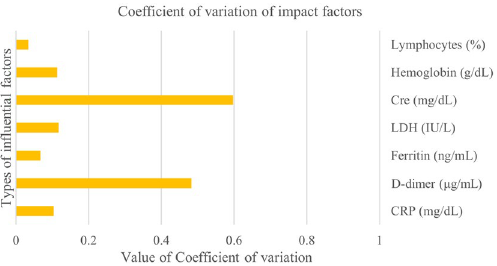
Figure 2. The coefficient of variation of each predictor in different training